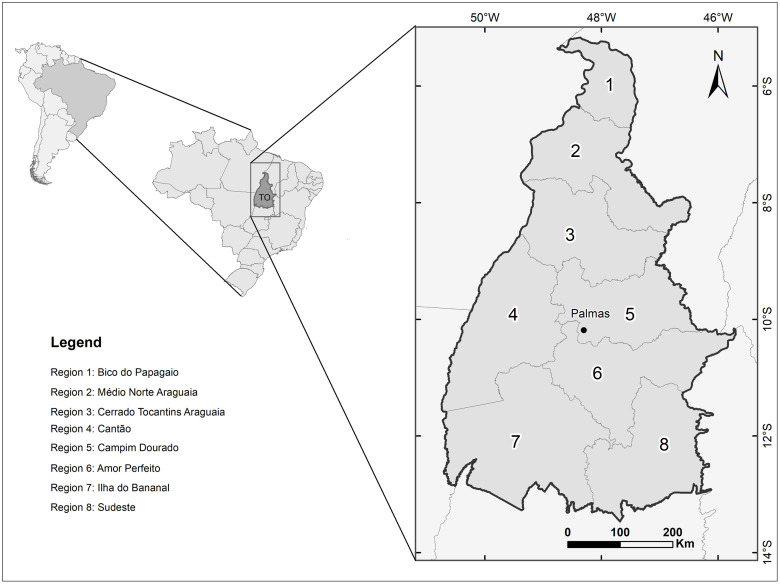
Health regions, Tocantins, Brazil.